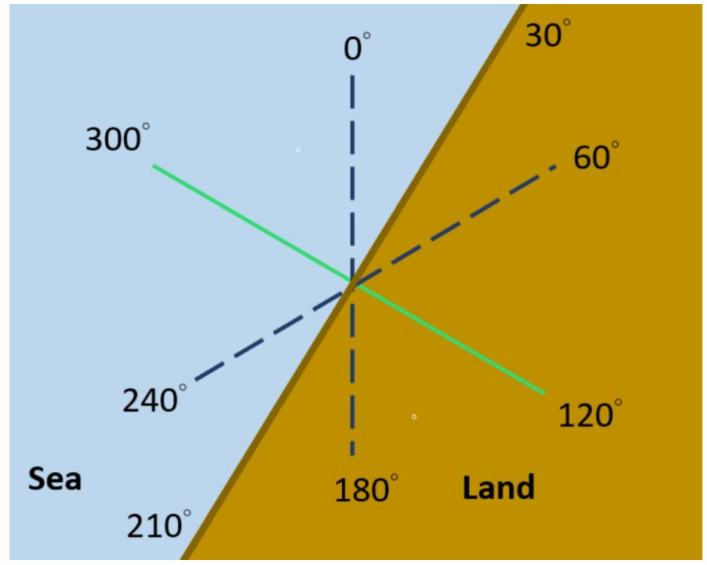
Figure 11. Schematic diagram of the observation site.